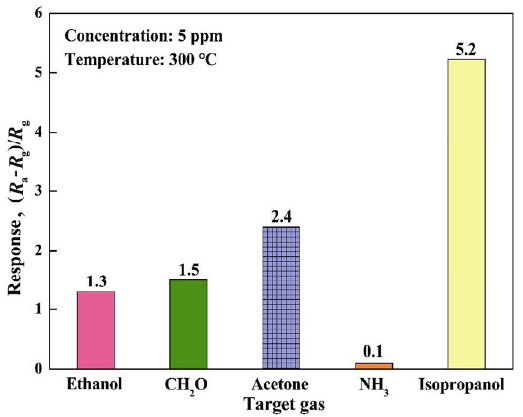
Fig. 12 Responses of 5Ag–In sensor to five different gases at 300 . ℃